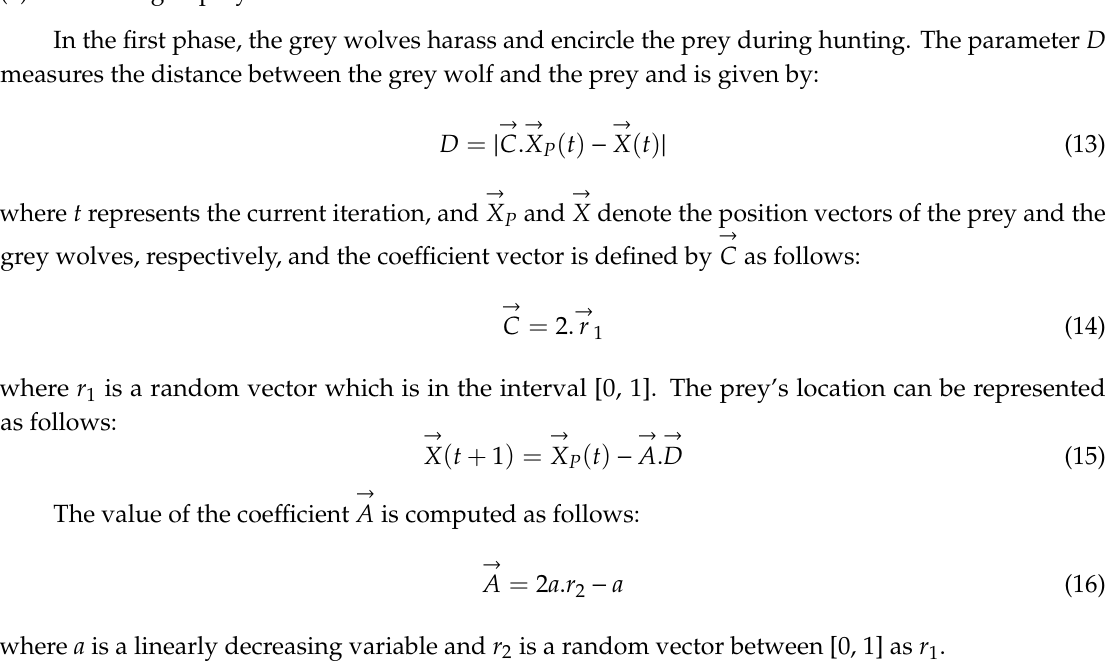
Figure 7. The social hierarchy of grey wolves [104].